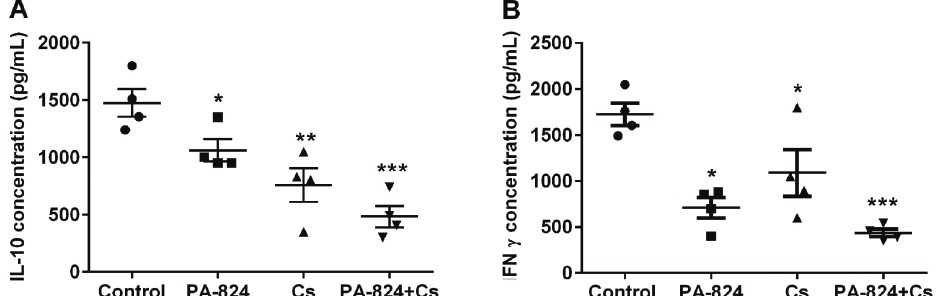
Figure 3. IL-10 and IFN- g secretions in the infected mice lungs after administration of PA-824, CS or the combination of both. Lung cells from individual mice were cultured and IL-10 ( A ) and IFN- g ( B ) secretions in the cell culture supernatants were measured by ELISA. Data are reported as means ± SD. CS: Cordyceps sinensis (Berk.) Sacc.; IFN- g : interferon- g ; IL-10: interleukin-10. *P o 0.05, **P o 0.01; ***P o 0.001, compared to control